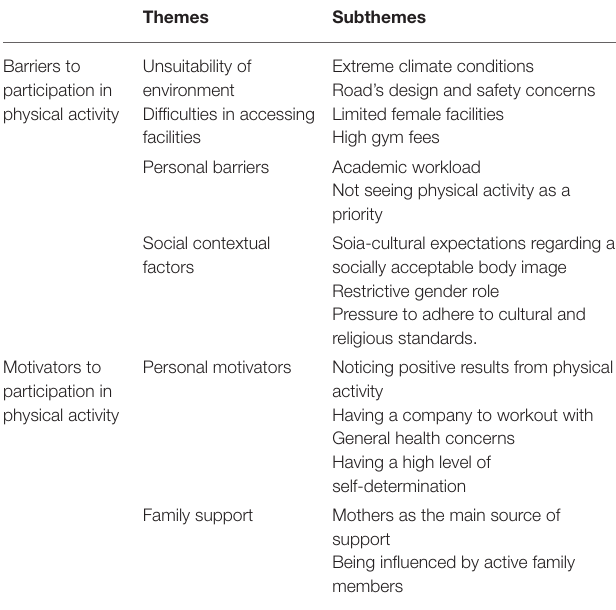
TABLE 6 | Summary of the main themes and the subthemes from the in-depth